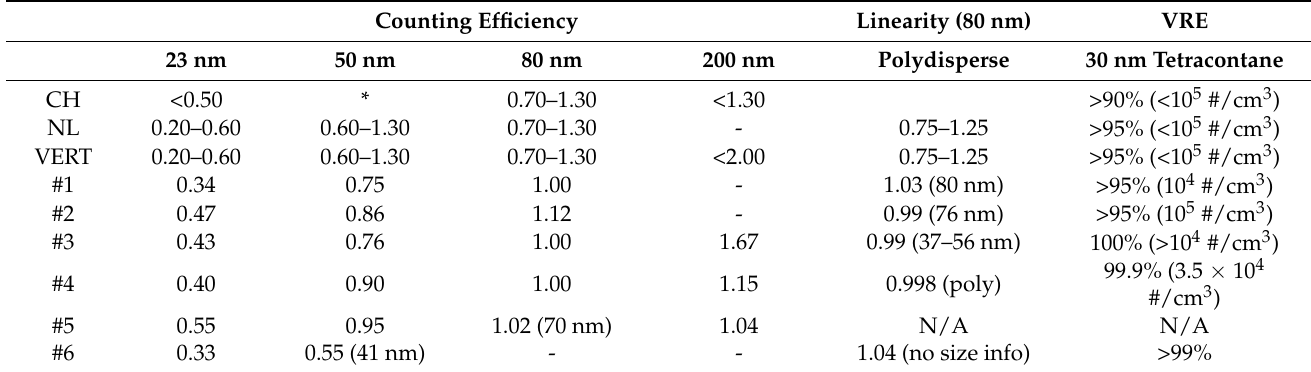
Table 2. Requirements for PTI sensors at different regulations (CH, NL, VERT) and calibration values of the PTI sensors as provided by the manufacturers.